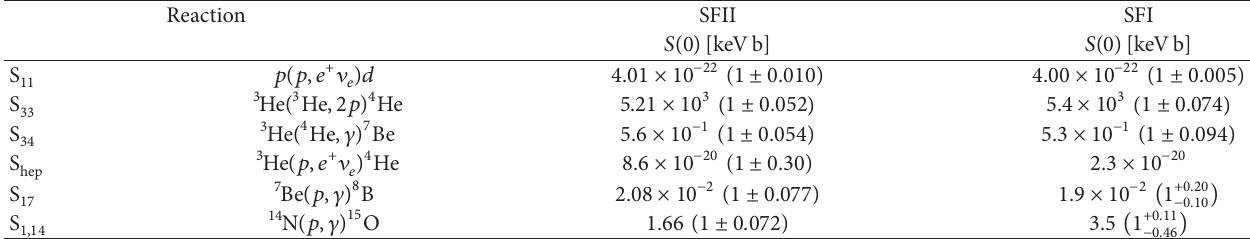
Table 2: Standard astrophysical factors and uncertainties for key nuclear reactions in the 𝑝𝑝 -chains and CNO-bicycle. SFII represents the state-of-the-art [55]; SFI [56] shows, for comparison, the situation around